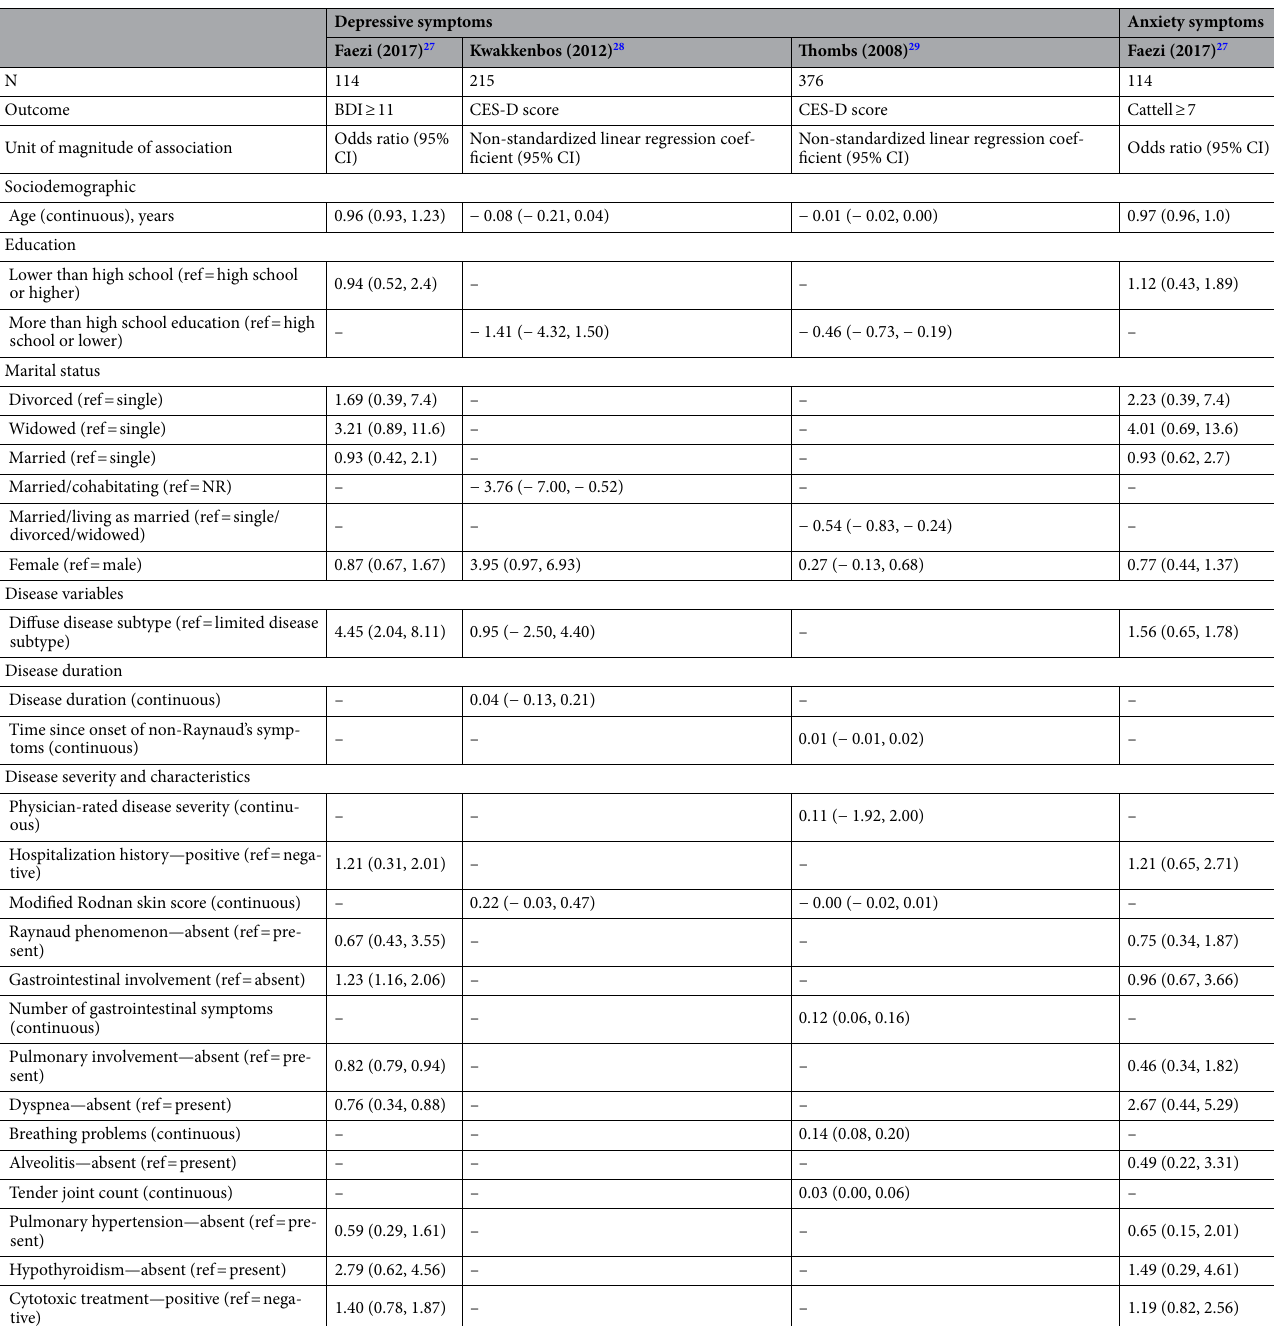
Table 3. Factors associated with mood or anxiety symptoms in multivariable analyses a . BDI beck depression inventory, Cattell Cattell Anxiety Self-assessment Scale, CES-D center for epidemiological studies-depression, NR not reported. a Odds ratios and linear regression coefficients of some included studies were reported here in the opposite direction from the primary study to have the same reference or direction as the other included